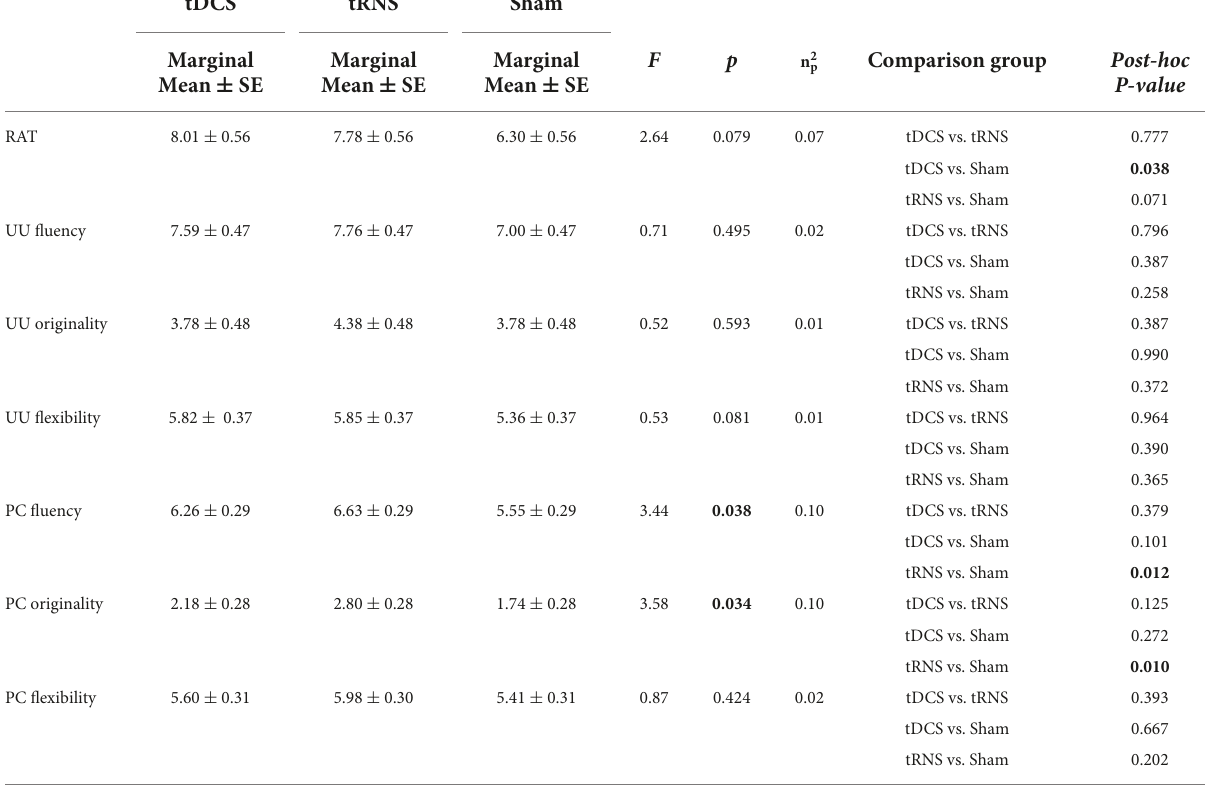
TABLE 3 Differences among groups in remote association test (RAT), unusual uses (UU), and picture completion (PC) scores during stimulation after controlling for baseline scores.